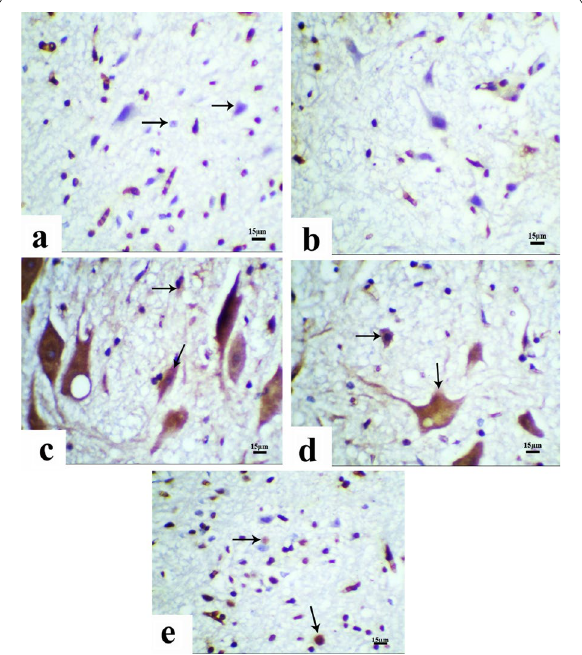
Fig. 12 Photomicrographs obtained from sections of cerebral cortex a : of control rat showing caspase-3 expression in the cytoplasm of few granular and pyramidal cells (arrows). b : obtained from ALA-treated animal showing normal caspase-3 expression. c : section of reserpine-treated rat showing an increase in number of cells with positive caspase-3 expression (arrows). d : section obtained from animal treated with reserpine and paroxetine showing positive caspase-3 expression in the cytoplasm of considerable number of cells (arrows). e : section obtained from depressed animal treated with ALA and paroxetine showing nearly normal caspase-3 expression appeared in few pyramidal and granular cells